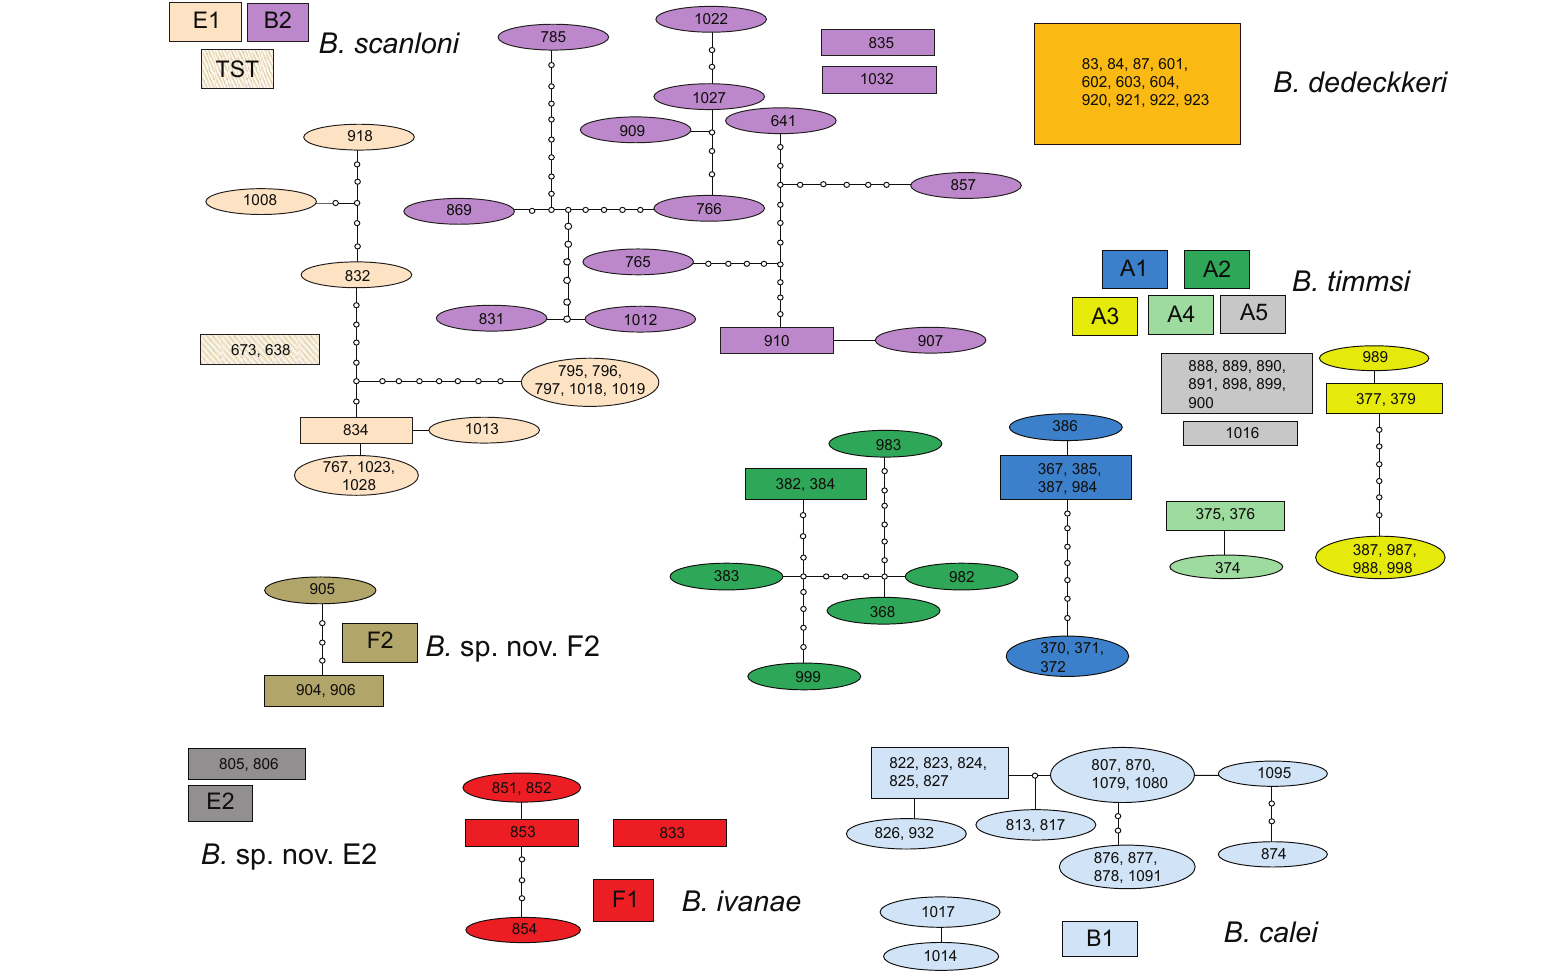
Fig. 3. Parsimonius network, based on cOI sequences of the Bennelongia barangaroo lineage. squares represent ancestral sequences (or haplotypes), small circles missing haplotypes. the size of squares and large ovals is proportional to the number of individuals with the same sequence in the analysed population. The network was constructed at the 95% probability limit, which includes up to 8 mutation steps for connecting different sequences or haplotypes. Different phylogenetic clades are indicated by different colours, which match those used in Fig. 2 (page